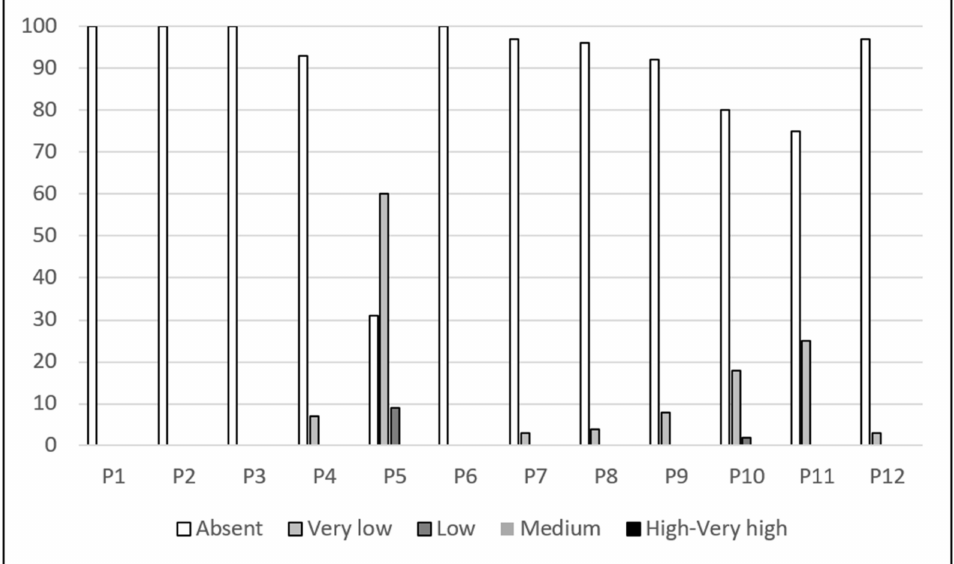
Figure 3. Incidence of Reticulitermes grassei in percentage of trees per plot (P) showing different damage